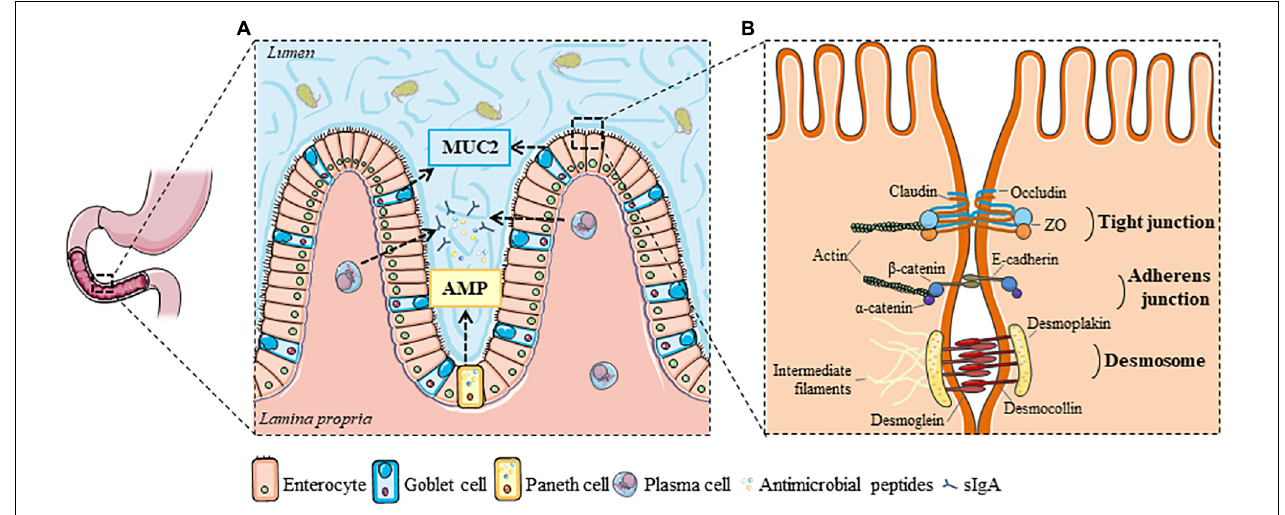
FIGURE 1 | Luminal and cellular elements of the duodenal barrier. (A) The intestinal lumen is separated from the epithelium by a mucus layer formed by mucin glycoproteins, mainly MUC2 from goblet cells, in which bacterial residence is limited by the secretion of antimicrobial peptides (from Paneth or epithelial cells) and sIgA (from plasma cells). (B) Tight junctions, adherens junctions and desmosomes are important cell-to-cell adhesion proteins that regulate the epithelial barrier function, and initiate and stabilize enterocyte adhesion in the gut. AMP, antimicrobial peptides; MUC2, Mucin 2; sIgA, secretory immunoglobulin A; ZO, zonula occludens. This figure was created with elements from